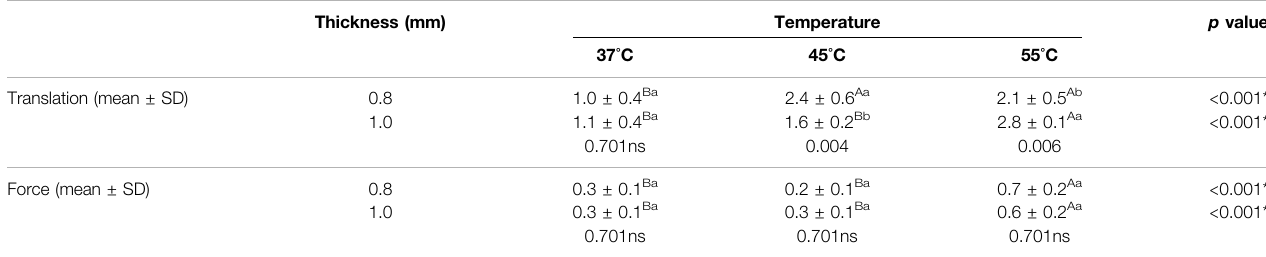
TABLE 1 | Mean ± standard deviation (SD) of translation and forces conducted on upper central incisor (tooth 21) by 4D-printed aligners of two thicknesses